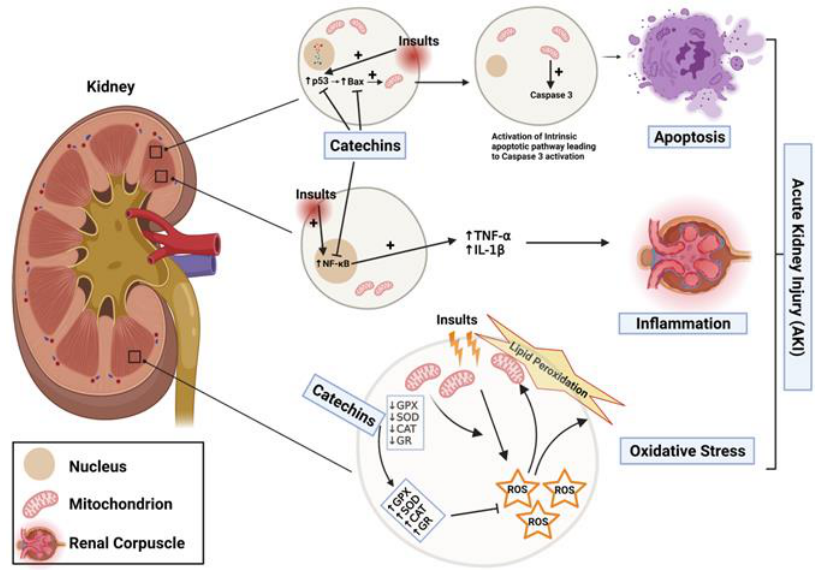
Figure 3. Catechins protect against AKI through different mechanisms. Catechins exert their reno-